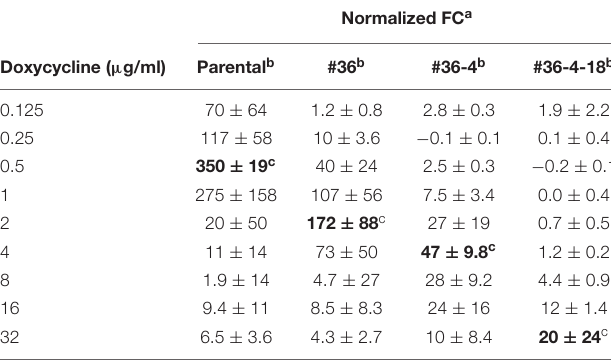
TABLE 5 | Molecular MIC analysis of avirulent Y. pestis Kim53pCD1 − pPCP1 − isolates with reduced doxycycline